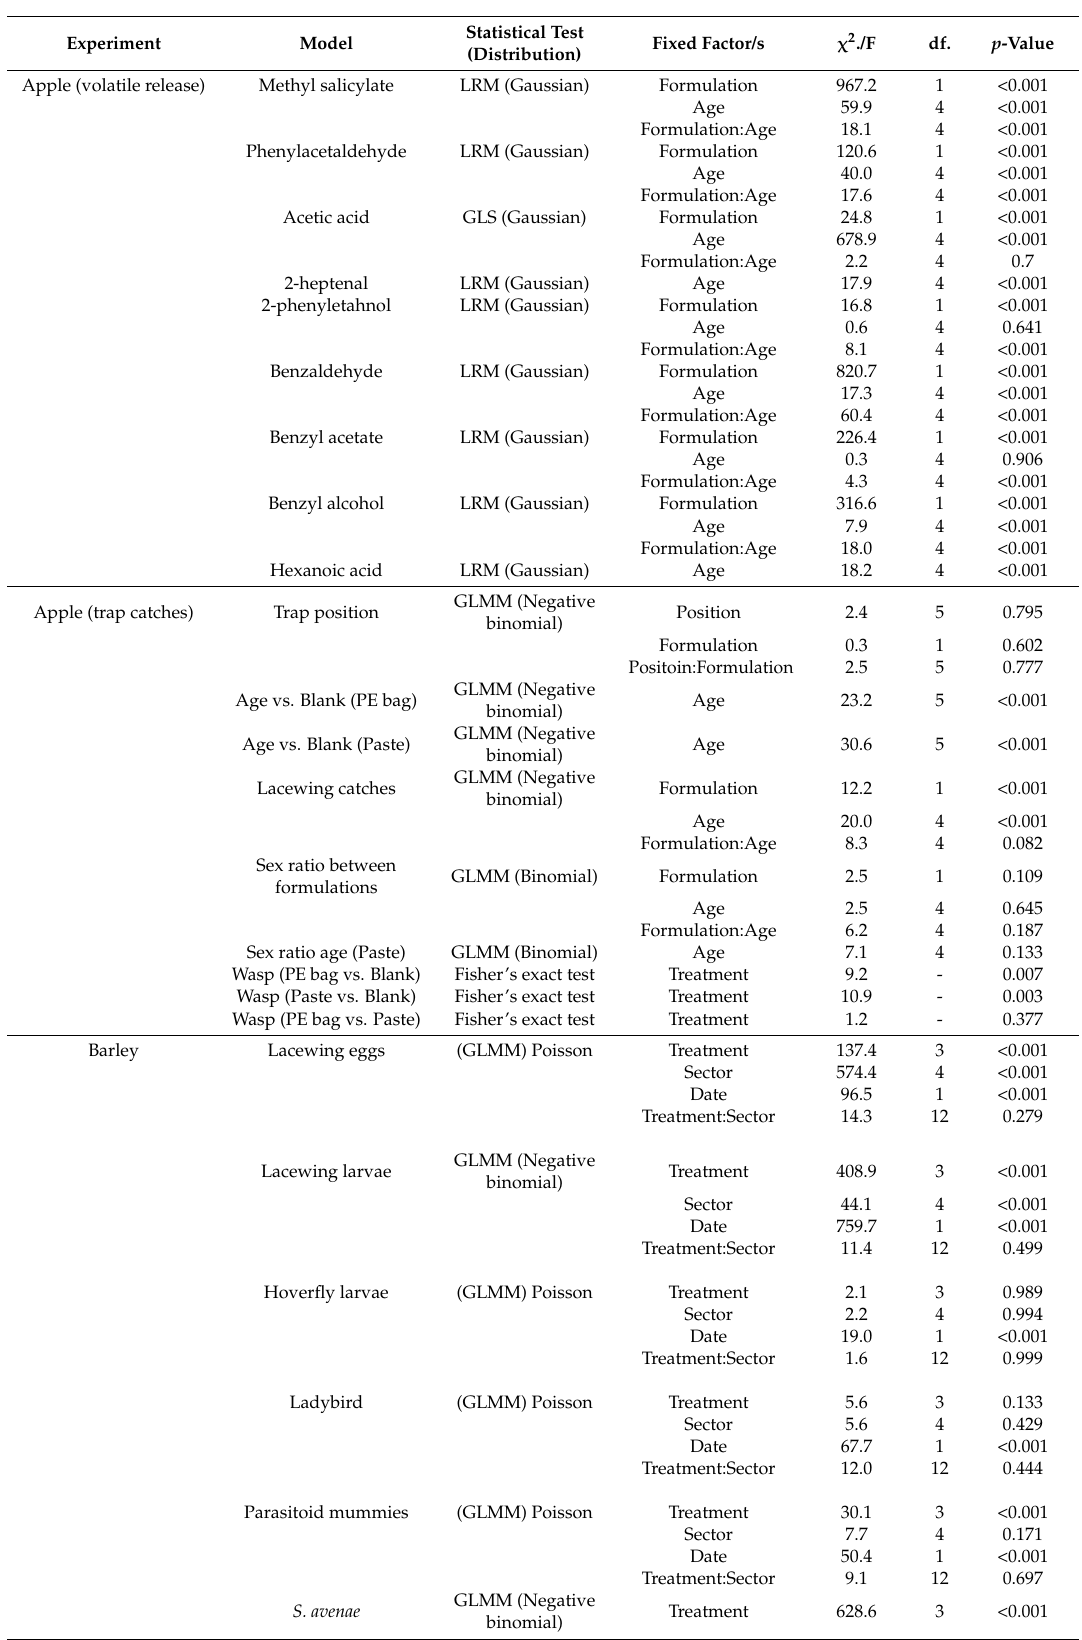
Table 1. Results of statistical